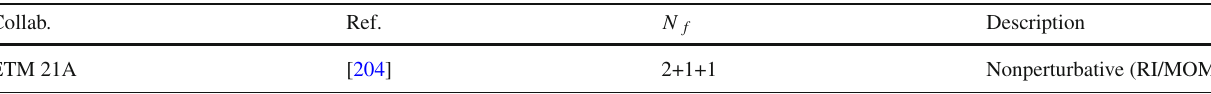
Table 85 Renormalization in determinations of m ud , m s and, in some cases m u and m d , with N f = 2 + 1 + 1 quark flavours Collab. Ref. N